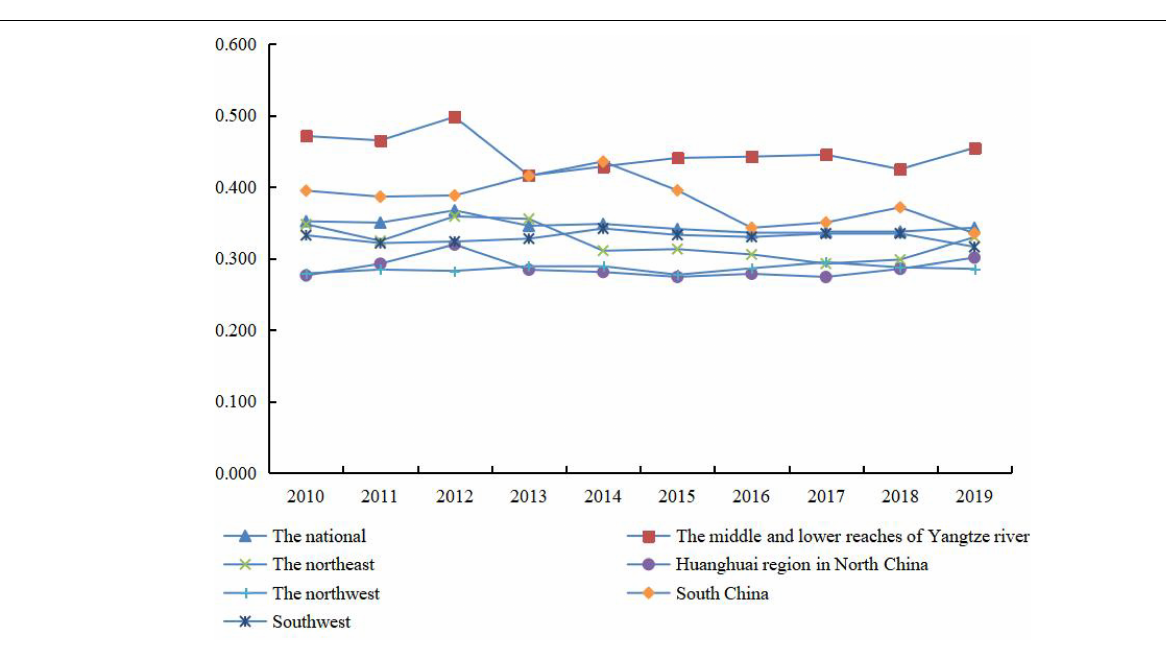
FIGURE 2 | Variation trend of vulnerability to flood disasters in China’s inland fisheries from 2010 to